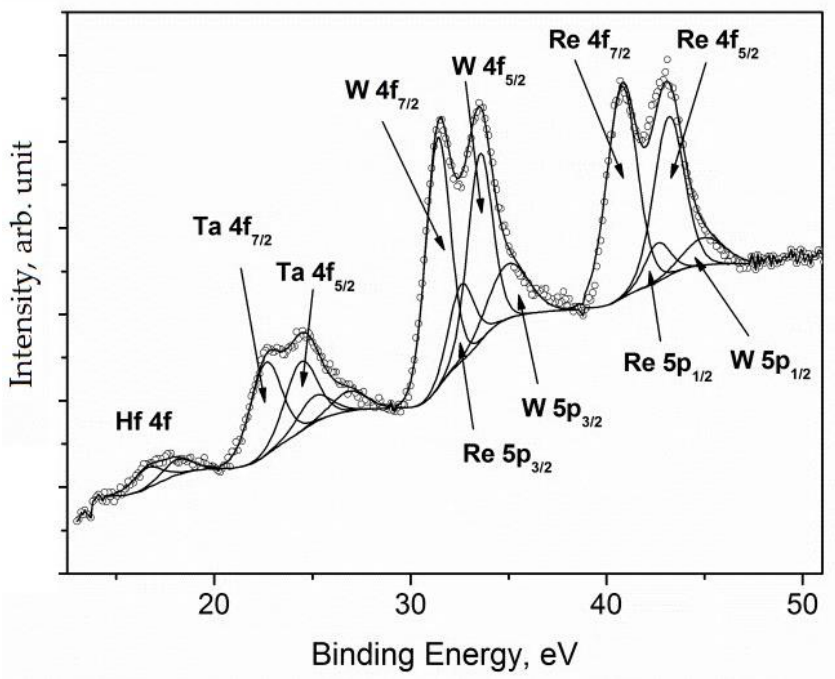
Figure 13. XPS spectrum of the 4f region acquired for the sample of CM186 superalloy [26].